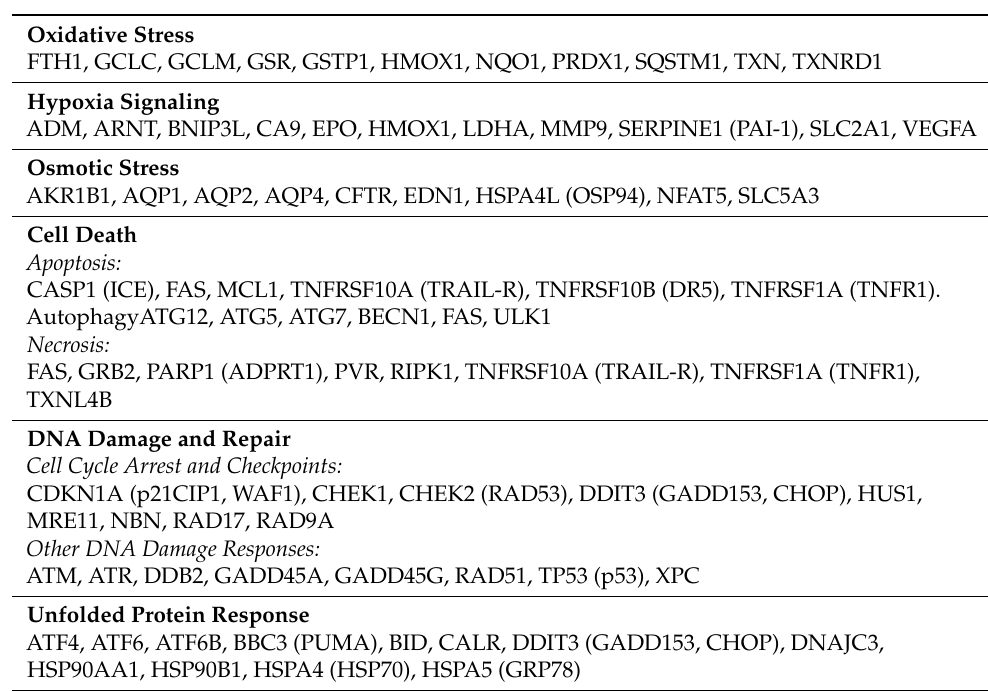
Table 1. The list of analyzed genes, contained in the RT 2 Profiler™ PCR Array Human Stress and Toxicity PathwayFinder (Qiagen,